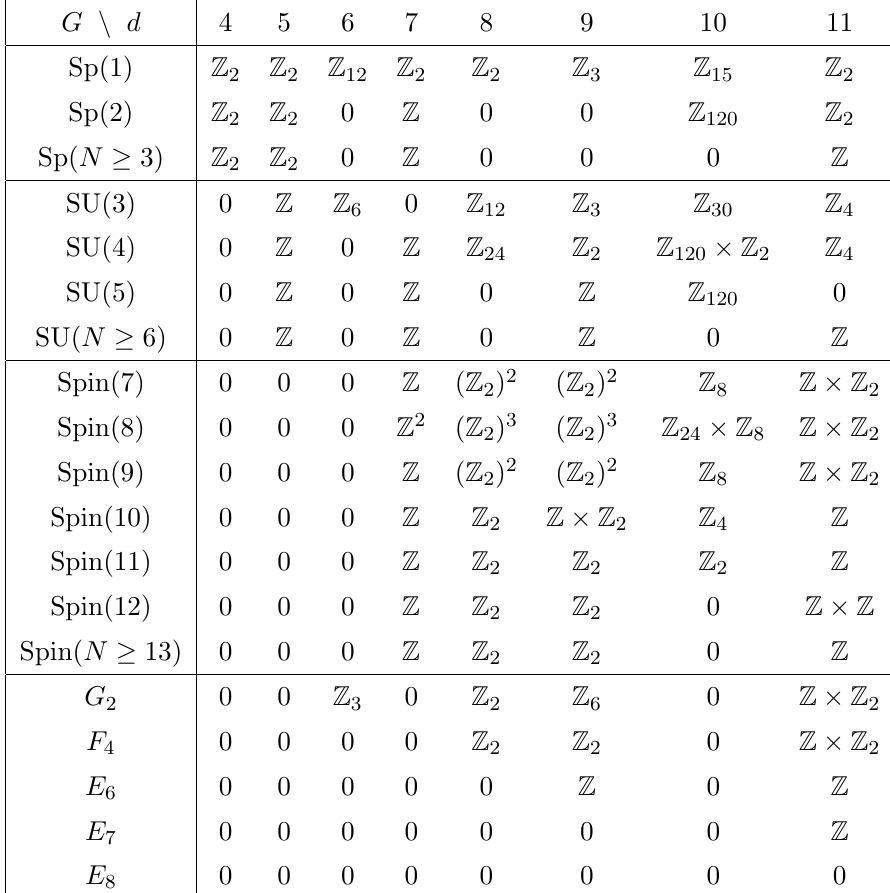
Table 1 . Homotopy groups of Lie groups (cid:25) d ( G ), 4 (cid:20) d (cid:20)